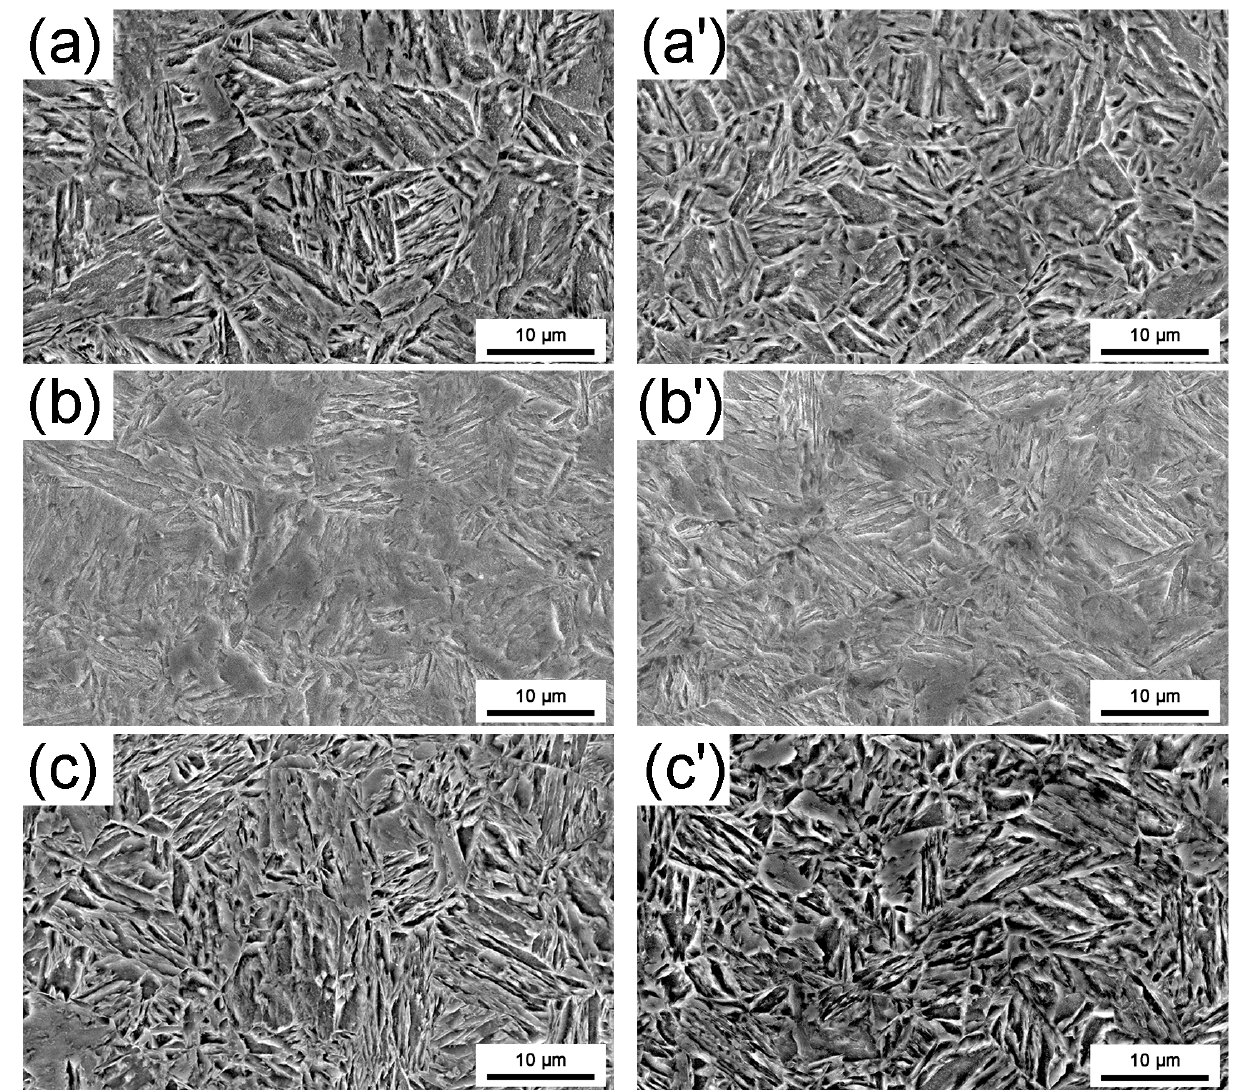
Figure 3. SEM images of marstenite quenching structure after heat treatment by the quenching oil of ( a ) traditional process and ( a’ ) CSP process, the water of ( b ) traditional process and ( b’ ) CSP process, and the 10 wt.% NaCl solution of ( c ) traditional process and ( c’ ) CSP process. EBSD characterization is shown in Figure 4. From the IPF images, the martensite blocks with low-angle boundaries can be clearly detected, and the martensite lath with similar orientations are distributed within the blocks. The martensite lath has straight boundaries, which are approximately parallel to the {111} plane of prior austenite, namely the habit plane. The four-level structure of martensite consists of prior austenite, martensite packet, martensite block, and martensite lath. A prior austenite grain is divided into three to five packets, which are collections of blocks with the same habit plane. Each block is composed of several laths with similar orientations. These laths are separated by retained austenite with a thickness of about 20 nm (unmeasurable by EBSD). These residual austenites contain a higher carbon content and are stable at room